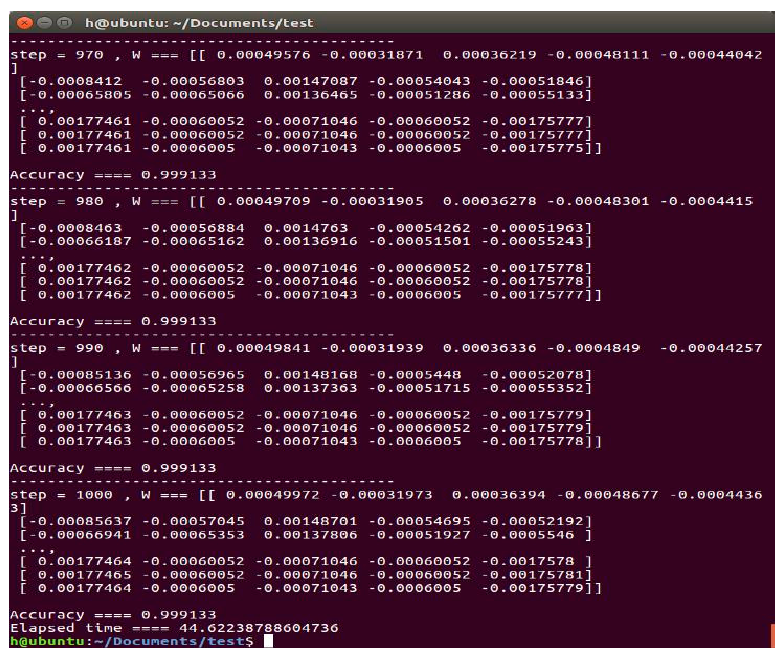
Figure 13. Accuracy and time of Adam in 5 cases.